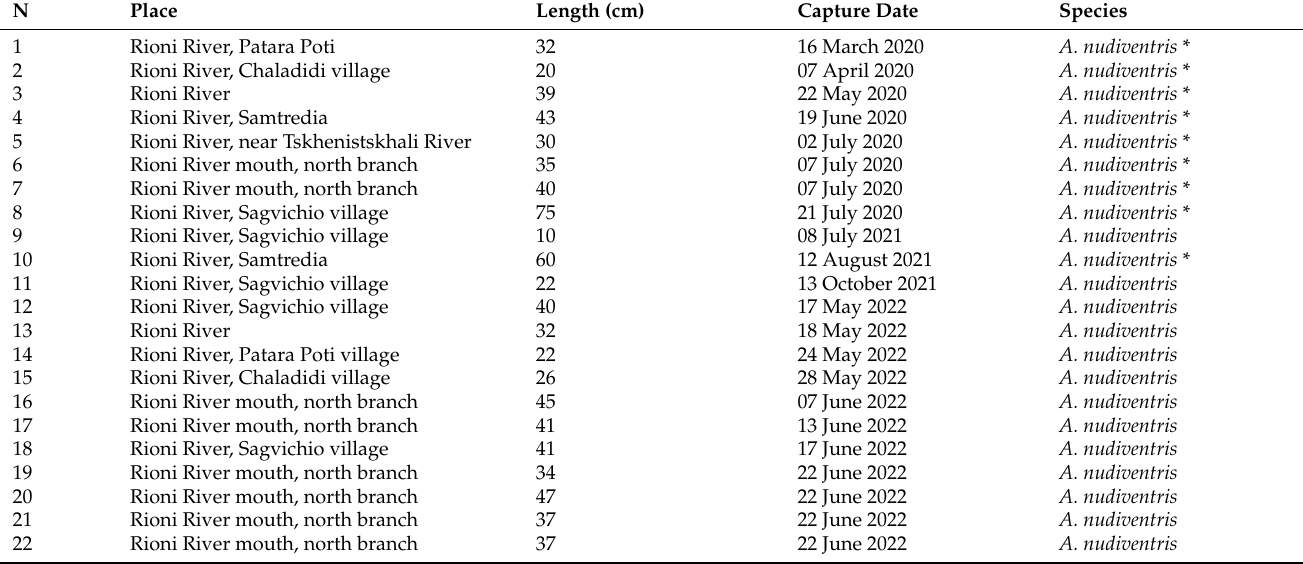
Table 1. Ship sturgeon captured in the Rioni River from 2020 to